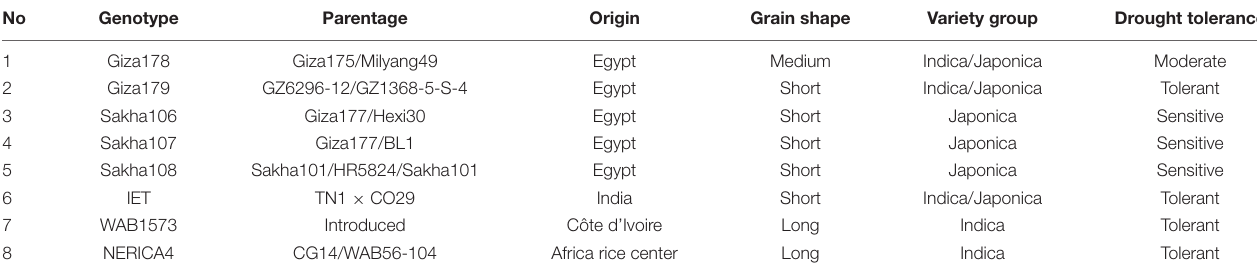
TABLE 1 | Origin and main characteristics of the eight rice genotypes used as parents in the half-diallel